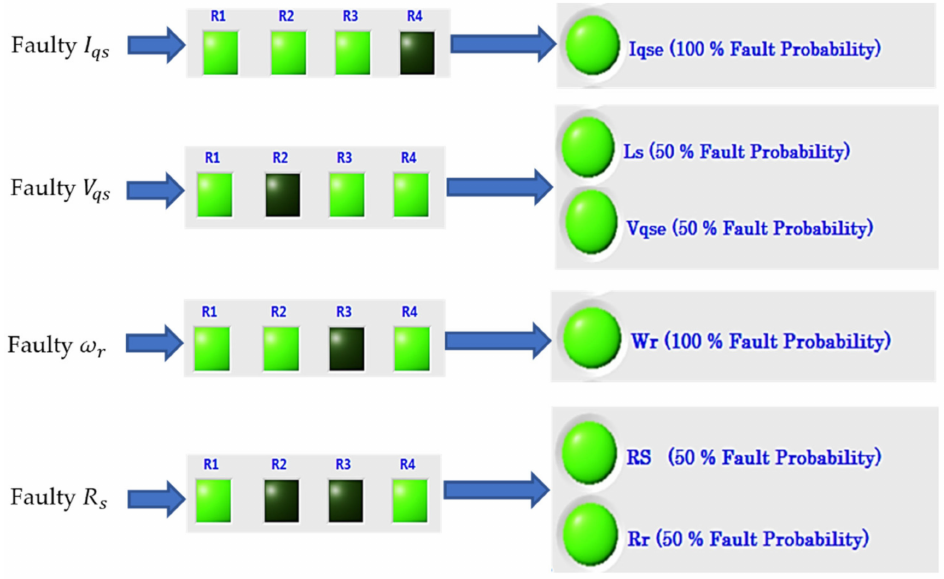
Figure 12. HMI for different residual conditions under